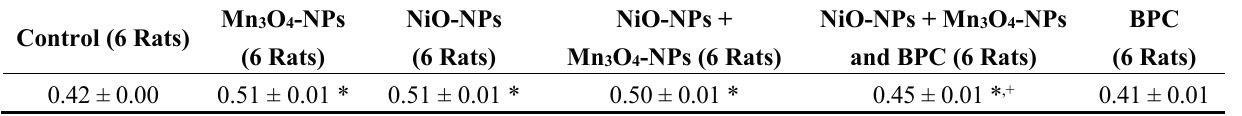
Table 7. The coefficient of genomic DNA fragmentation in the blood nucleated cells of rats after repeated intraperitoneal injections of NiO or Mn 3 O 4 nanoparticles, together or separately, and of their combination with background oral administration of the BPC (X ±